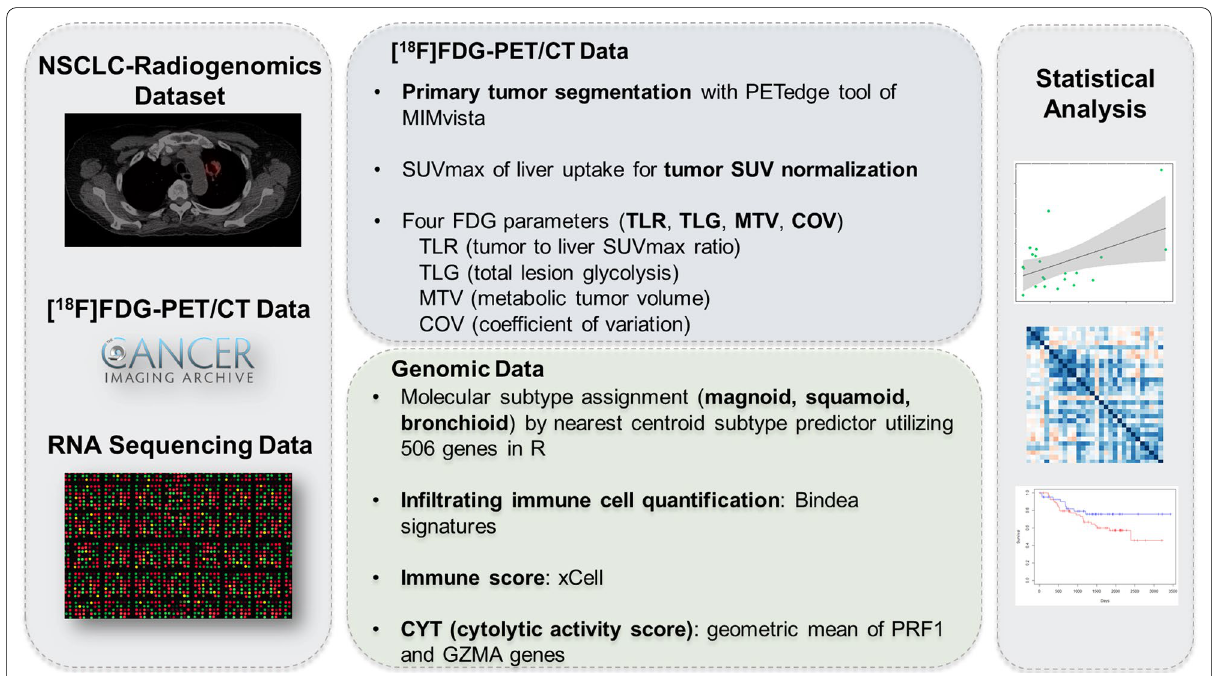
Fig. 1 Scheme of the study. 18 F‑FDG PET and RNA sequencing data were obtained from NSCLC radiogenomics dataset in TCIA. Four 18 F‑FDG parameters were measured from manually assigned ROI of primary tumor. RNA sequencing data used for molecular subtype assignment and immune‑related quantification. Statistical analysis was performed by integrating 18 F‑FDG parameters and genomic